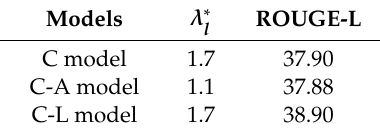
Table A4. Results of the validation for the hyperparameter the length penalty in each